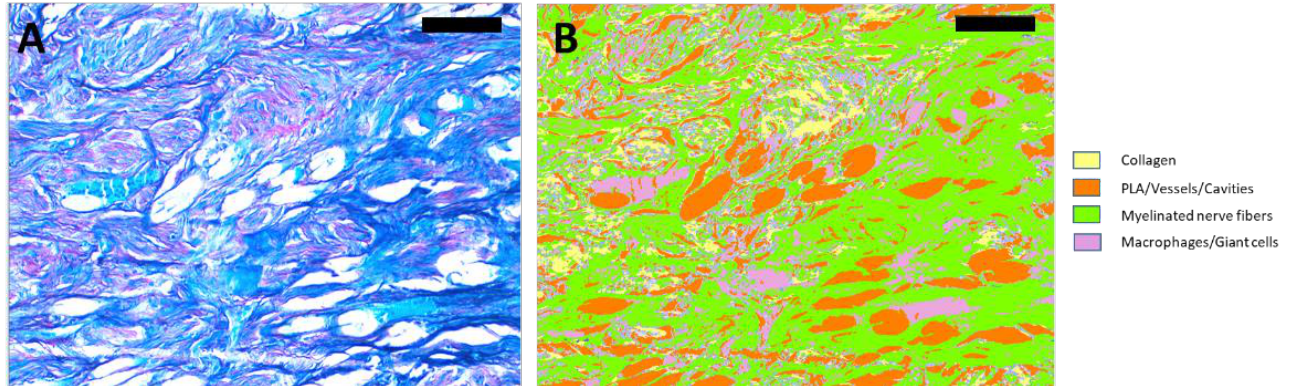
Figure 1. Example of a Luxol fast blue image and its segmentation. ( A ) Luxol fast blue image. ( B ) Segmentation of image ( A ). As can be observed with this example, Luxol fast blue images were segmented to quantify the area of collagen, PLA/vessels/cavities, myelinated nerve fibers and macrophages/giant cells. Collagen (red) is segmented in yellow, PLA/vessels/cavities (white) are segmented in orange, myelinated nerve fibers (dark blue) are segmented in green, and macrophages/giant cells (light blue) are segmented in purple. Scale bar = 100 µm.